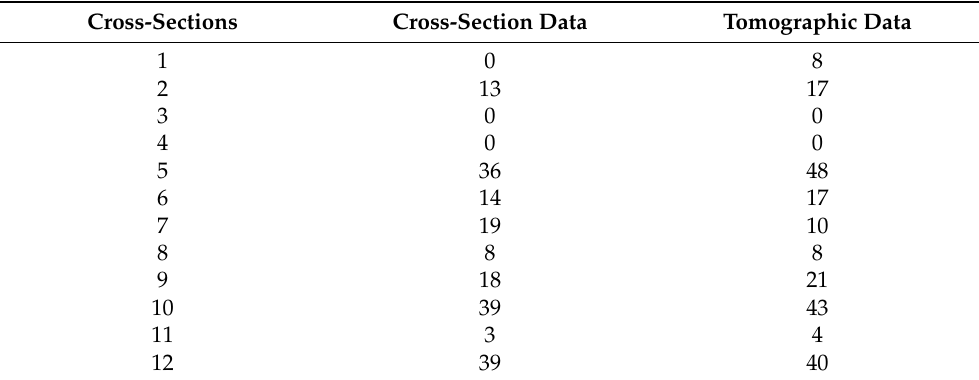
Table 6. Strength loss percentage values using Equation (10) with data from cross-sections and tomographic